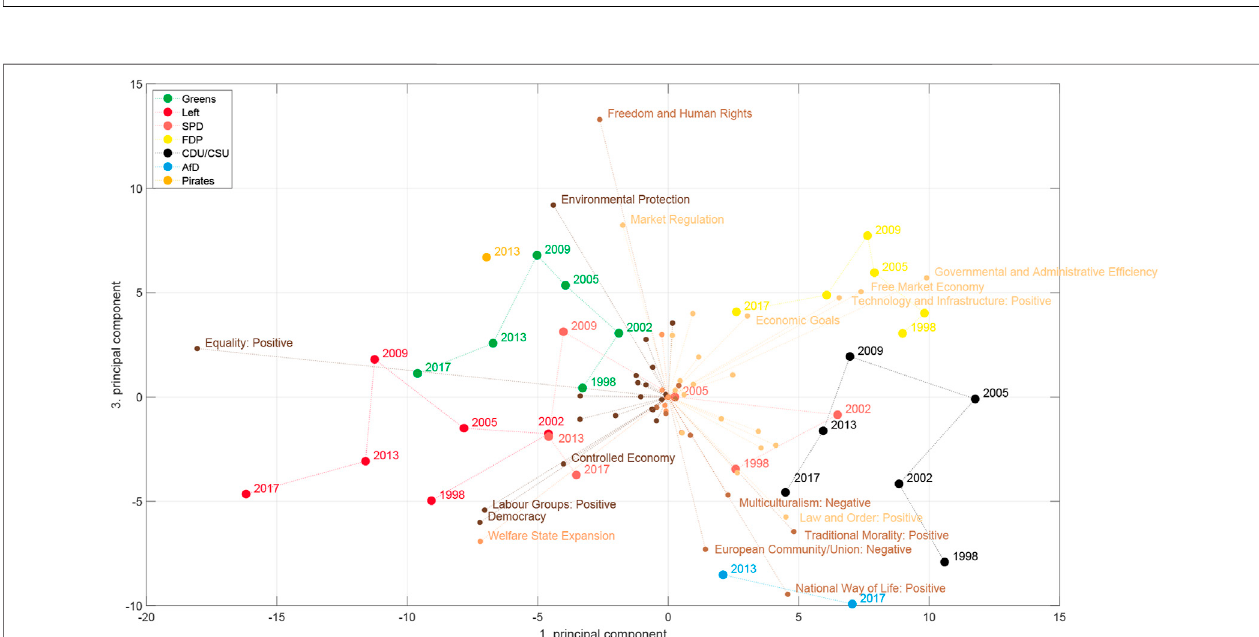
FIGURE 8 | Same as in Figure 7 but now for the 1st and the 3rd principal component.